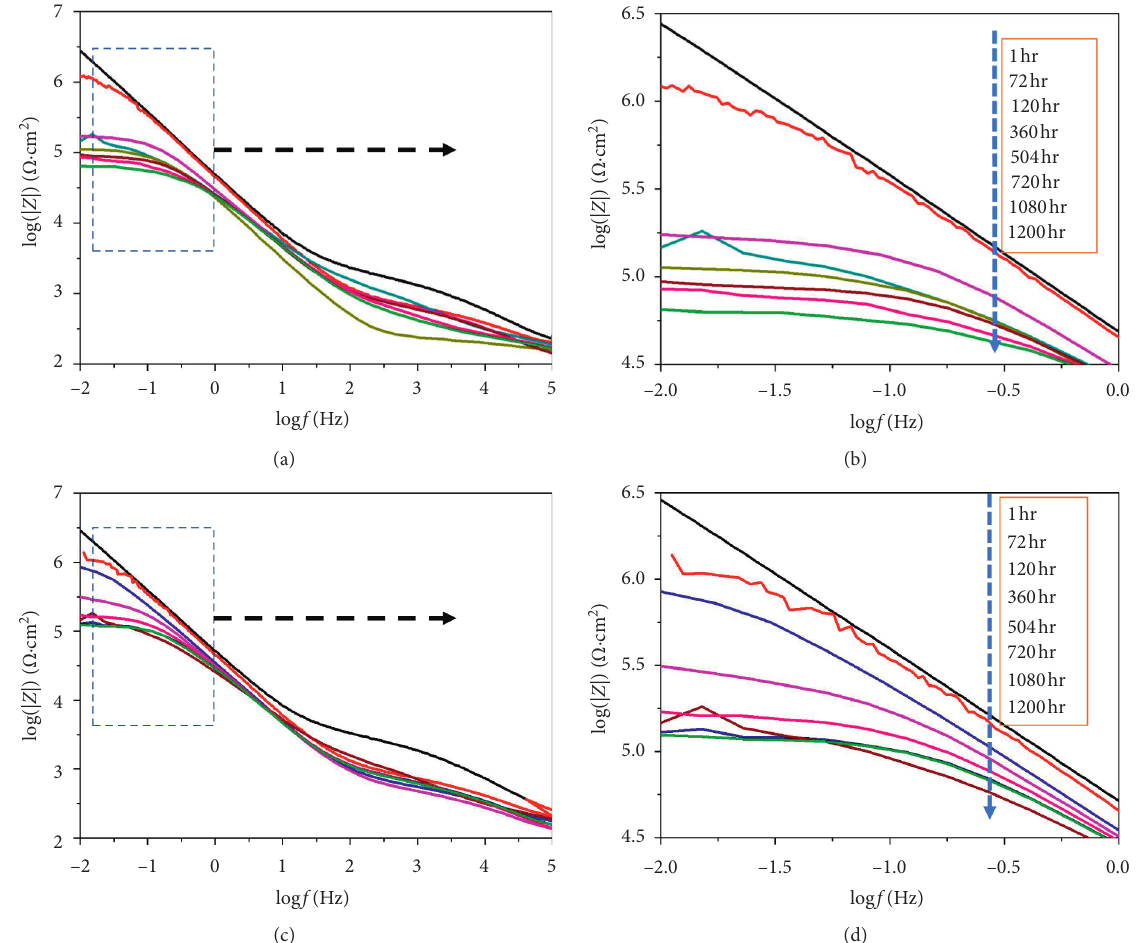
Figure 8: Impedance modulus plots of (a and b) CeLDH, (c and d) CeLDH-H with respective enlarged images for clear depiction at various immersion times, from 1h to